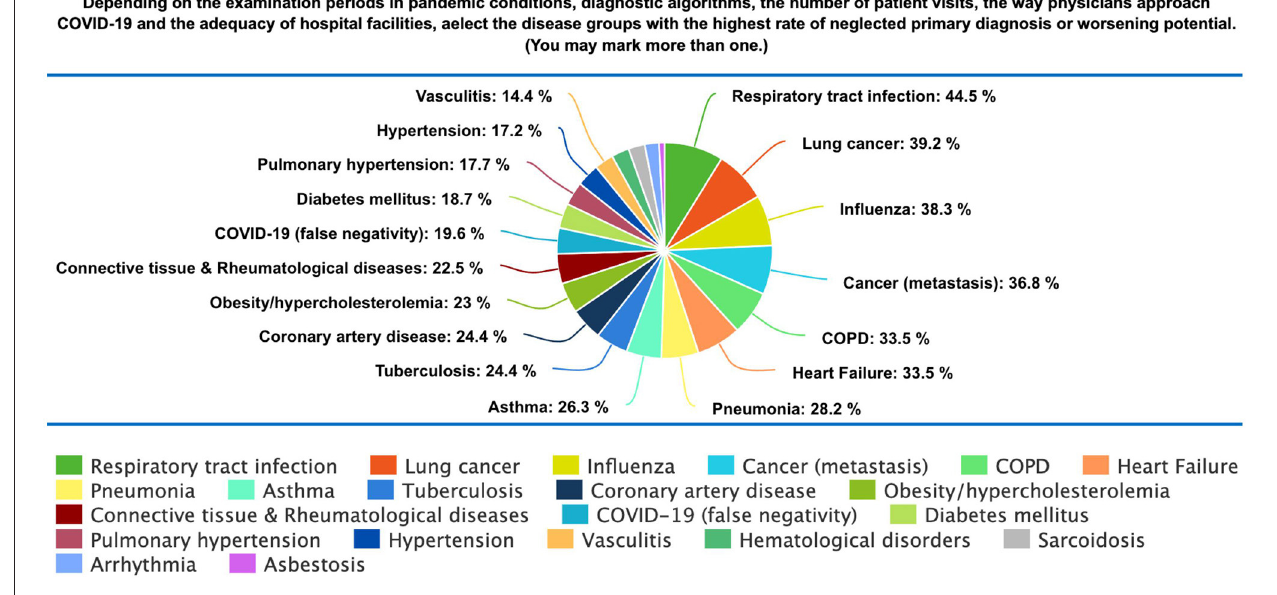
FIGURE 1 | Distribution of insufficiently diagnosed